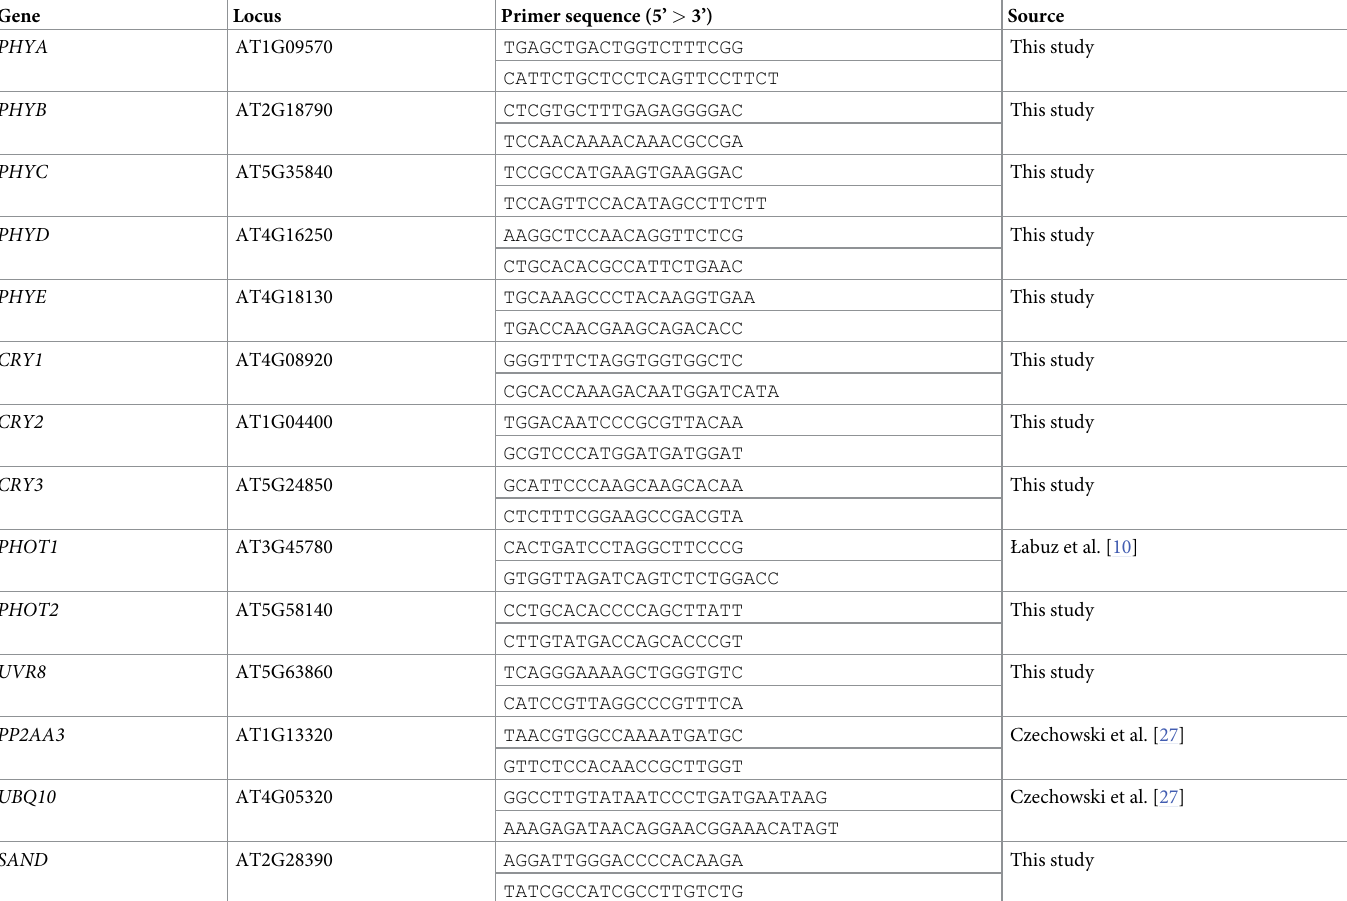
Table 2. List of primers used in this study.